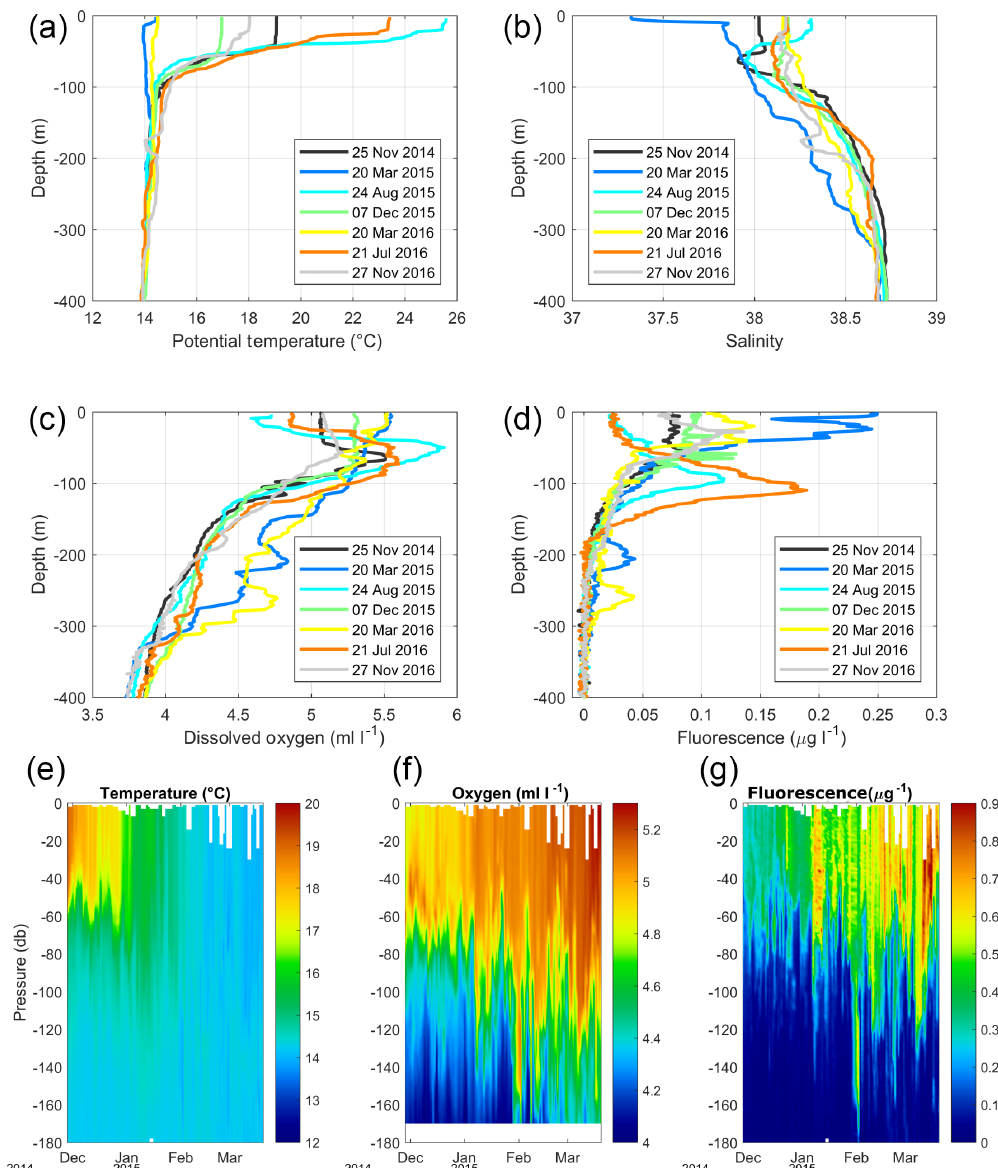
Figure 2. (a–d) Vertical profiles of potential temperature, salinity, dissolved oxygen and chlorophyll fluorescence, respectively, from CTD casts carried out during servicing at the mooring location; since density is controlled by temperature the thermocline depth is essentially equivalent to the pycnocline depth. (e–f) Daily vertical profiles of temperature, dissolved oxygen and chlorophyll fluorescence, respectively, from November 2014 to March 2015, as recorded by the moored